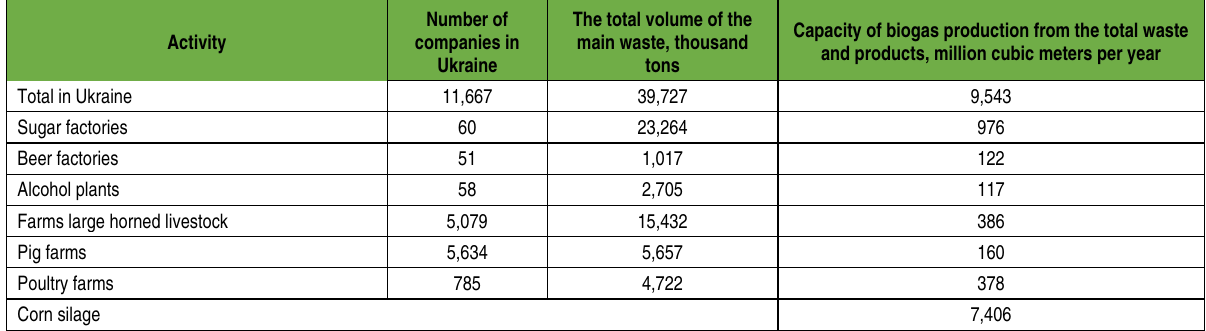
Table 5. The potential of biogas production in Ukrainian agriculture